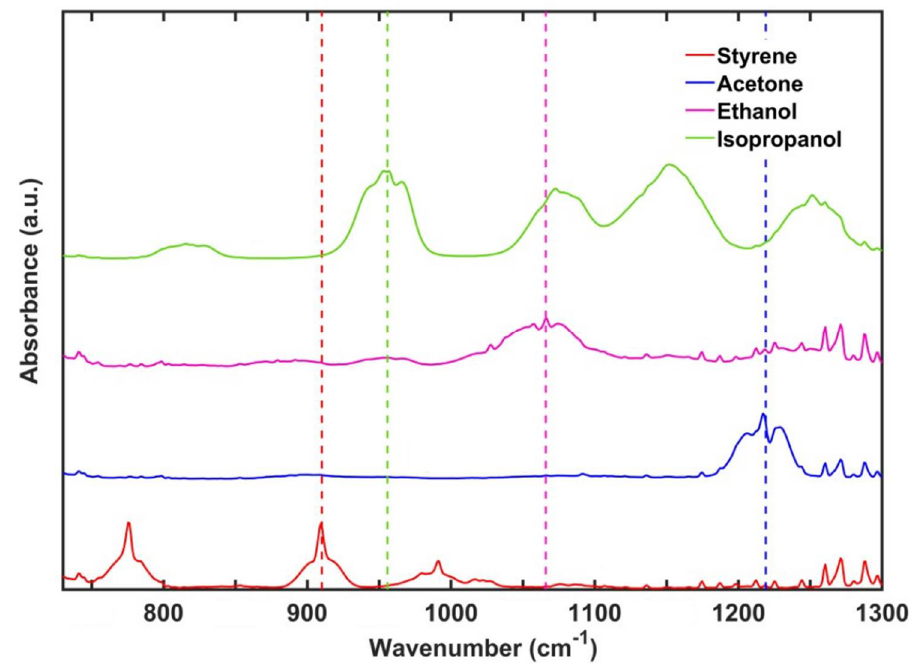
Figure 2. FTIR spectra of the studied VOCs in the MIR spectral region ranging between 750 and 1300 cm − 1 . Colored dashed lines highlight the absorbance peaks considered for the evaluation of the calibration curves of each VOC: styrene (red), acetone (blue), ethanol (pink) and isopropanol (green).